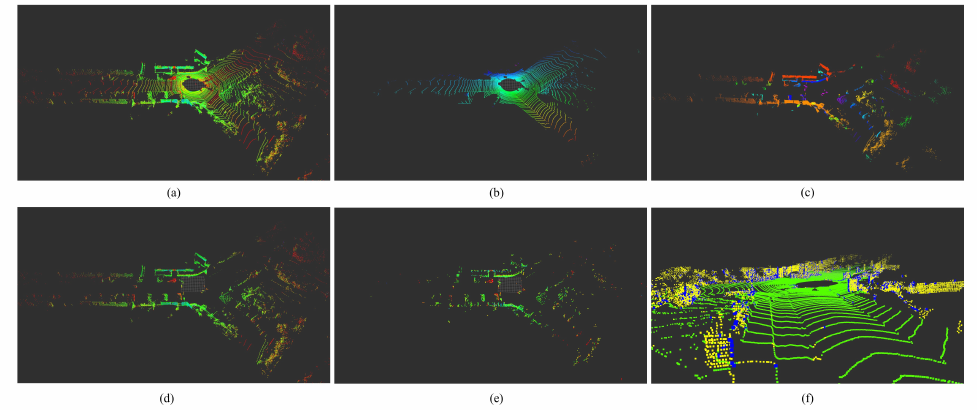
Figure 6. Feature extraction process for a scan (000000.bin) on sequence 00 of the KITTI odometry benchmark. ( a ) is all laser points in the current frame. ( b ) is the result of ground segmentation. ( c ) is the segmentation result of non-ground point cloud clusters, and different colors represent different point cloud clusters obtained by LiDAR segmentation. ( d , e ) represents the extracted planar points and edge points respectively. ( f ) is the visualization of ground points, planar points and edge points. The green ones represent the ground points, the yellow ones represent the planar points, and the blue ones represent the edge points